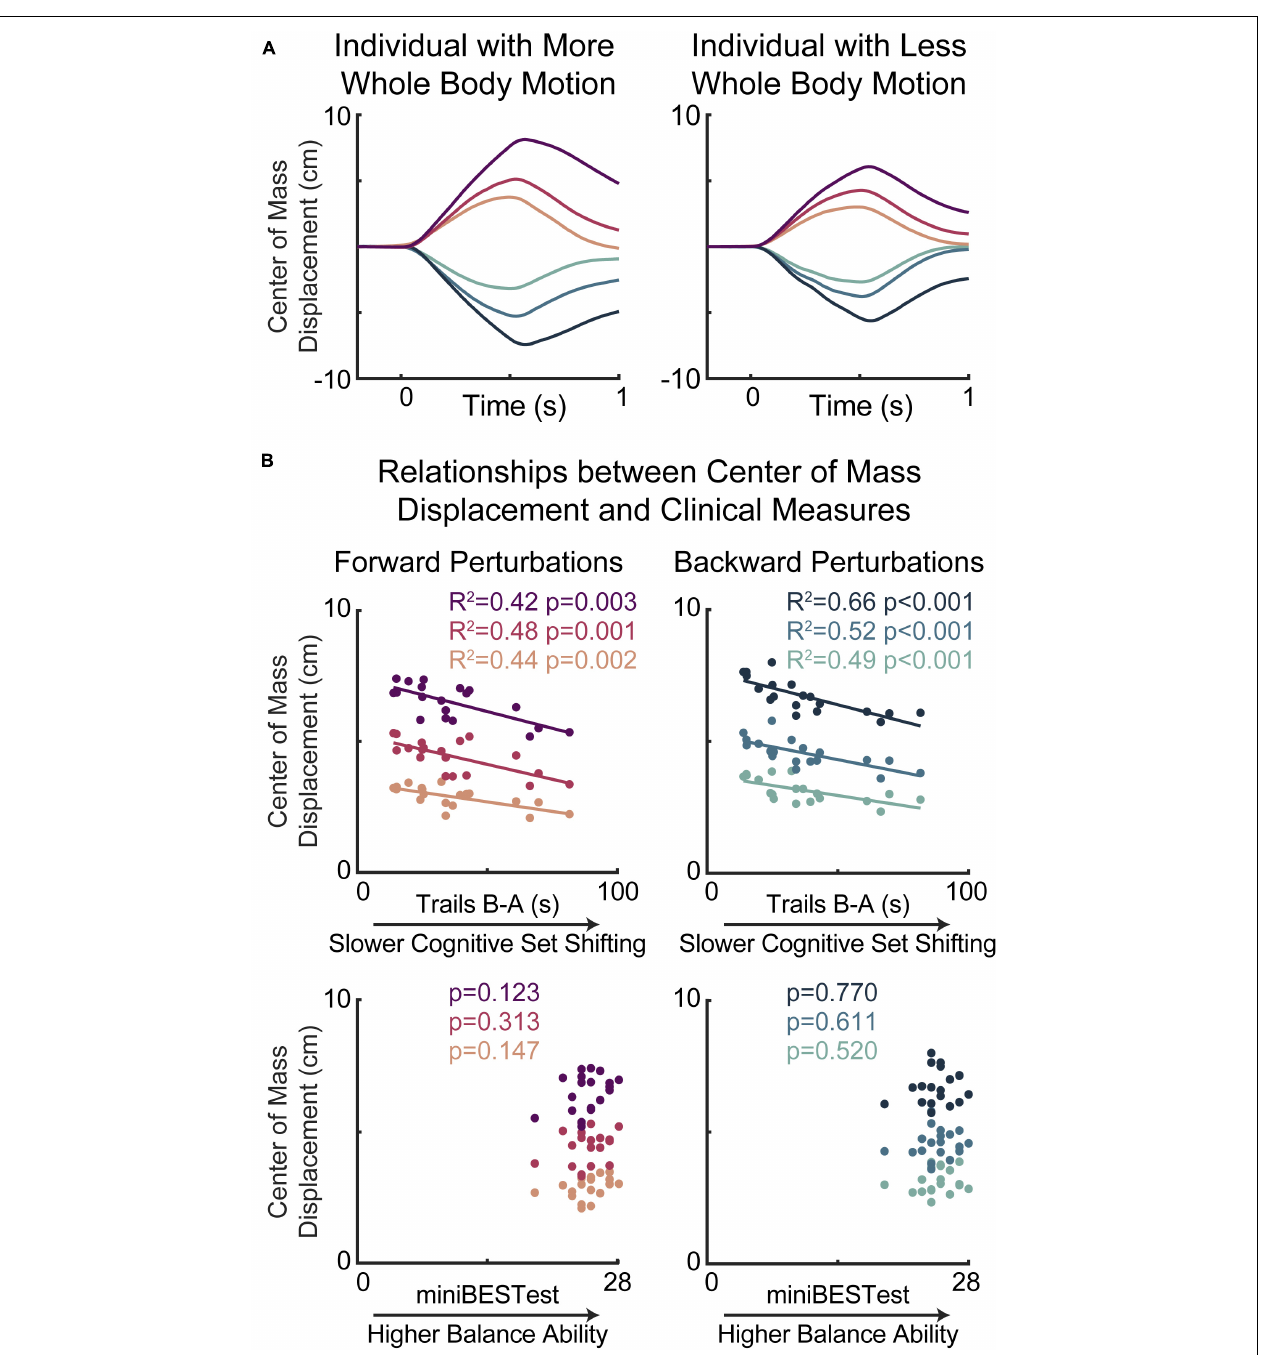
FIGURE 3 | Slower cognitive set shifting was associated with stiffer behavioral responses to perturbation. (A) Center of mass displacements are shown for two individuals with more (left) or less (right) whole body motion for each of the perturbation types, with forward movements of the floor (resulting in backward leaning posture) represented in magentas and backward movements of the floor represented in blues, with darker colors for larger perturbations. (B) Peak center of mass displacements are plotted against cognitive set shifting scores (middle) and clinical balance scores (bottom) for forward (left) and backward (right) perturbations for each perturbation